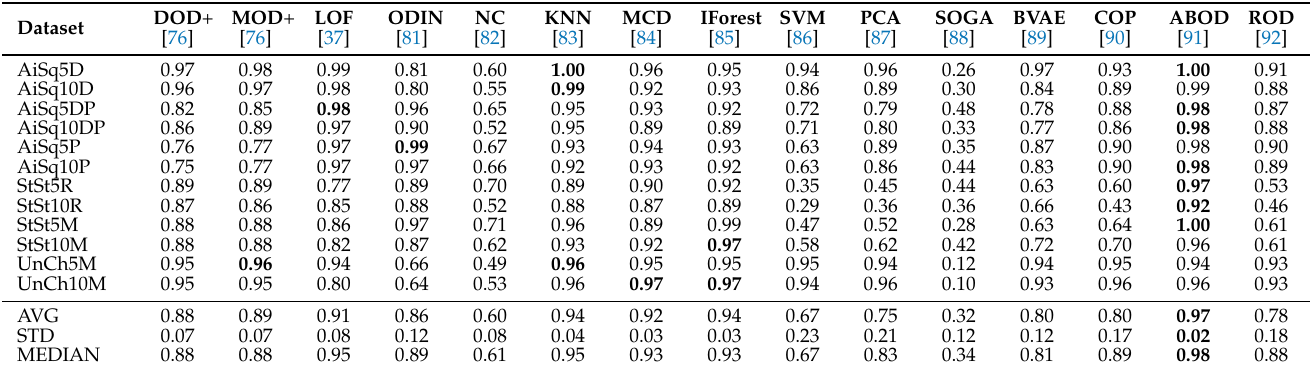
better than the best baseline trajectory outlier detector in Table 2—IBAT with the optimal parameter settings. The properties of these methods were described in Ref. [76]. Table 3. AUC results of tabular outlier detectors using with MiPo (the best per row is in bold).